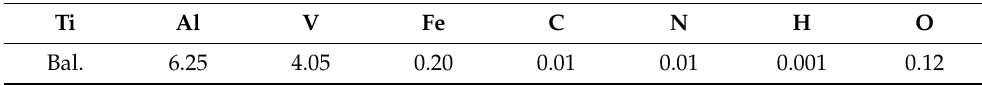
Table 1. Chemical composition (wt.%) of the Ti-6Al-4V